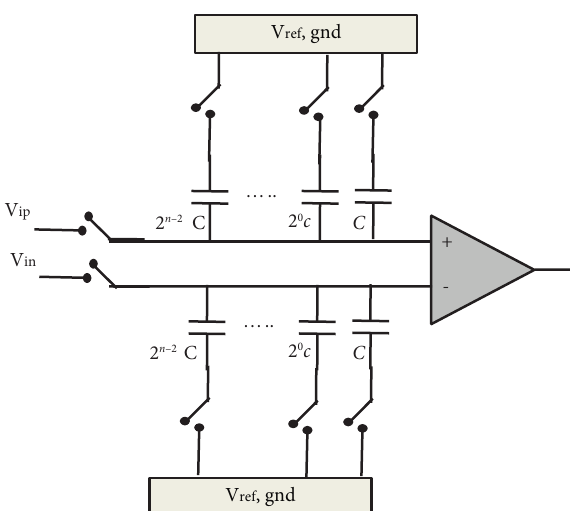
Figure 9: Fully diferential structure of